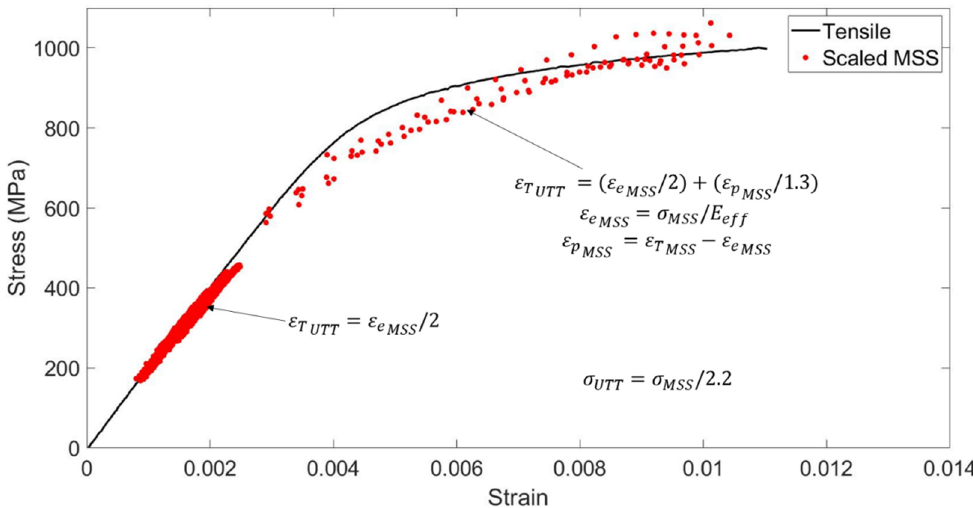
Figure 5. An overlay of data collected from five MSS tests conducted on Sample number 8 on the corresponding UTT stress-strain curve.